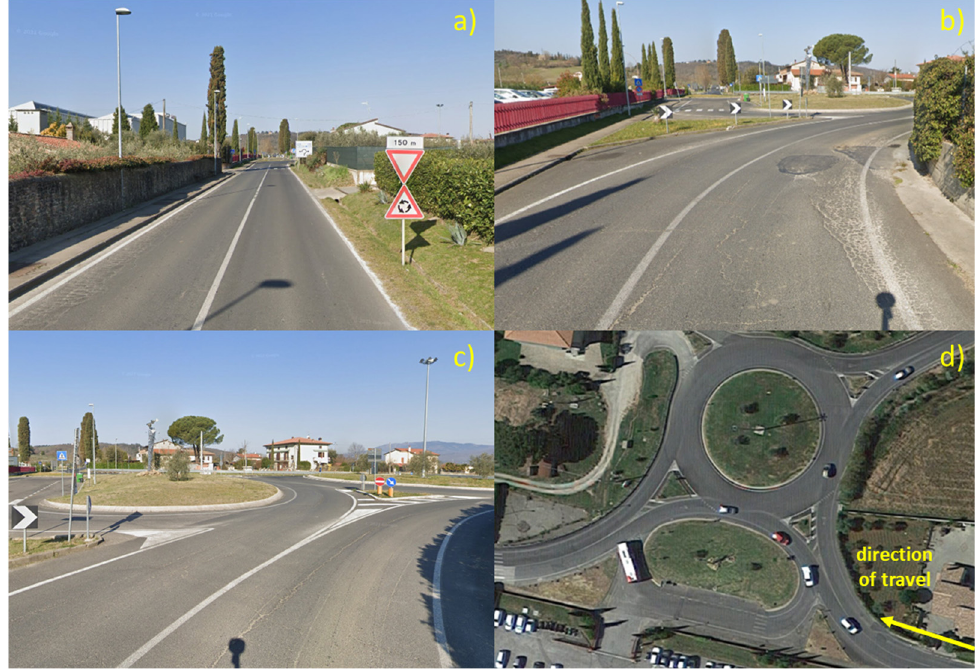
Figure 3. Unclear roundabout, modified from Google Street View. Moreover, the “not trucks allowed” symbol (D), may induce the implication that cars are not prohibited; the “go around” divider with the right arrow on the left sign (E), suggests the driver the possibility to go straight, and the yellow and black stripes sign that indicates to pass on the right, seems to also suggest that is possible to go straight. All those stimuli and information are ambiguous and may appear illogical considering that drivers must make decisions in a few seconds. Finally, the driver’s mental workload must also be considered. Drivers must be kept “active” by continuous stimuli, but too many stimuli may cause an information loss, such as in this case, because our brain cannot process too much information at the same time [11] (pp.